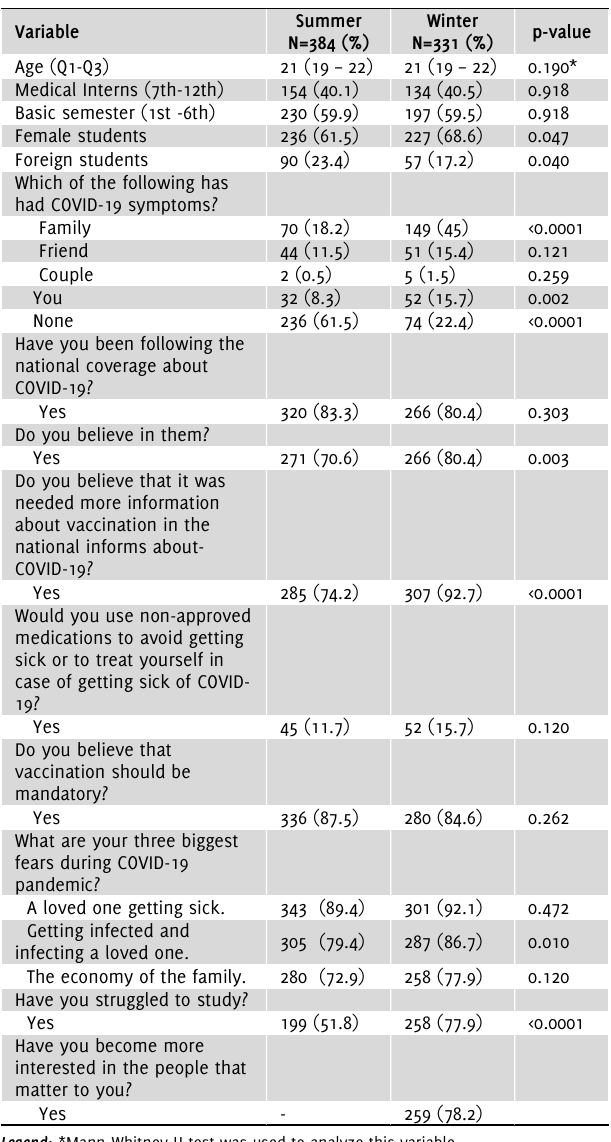
Table 1 . Comparison between summer and winter